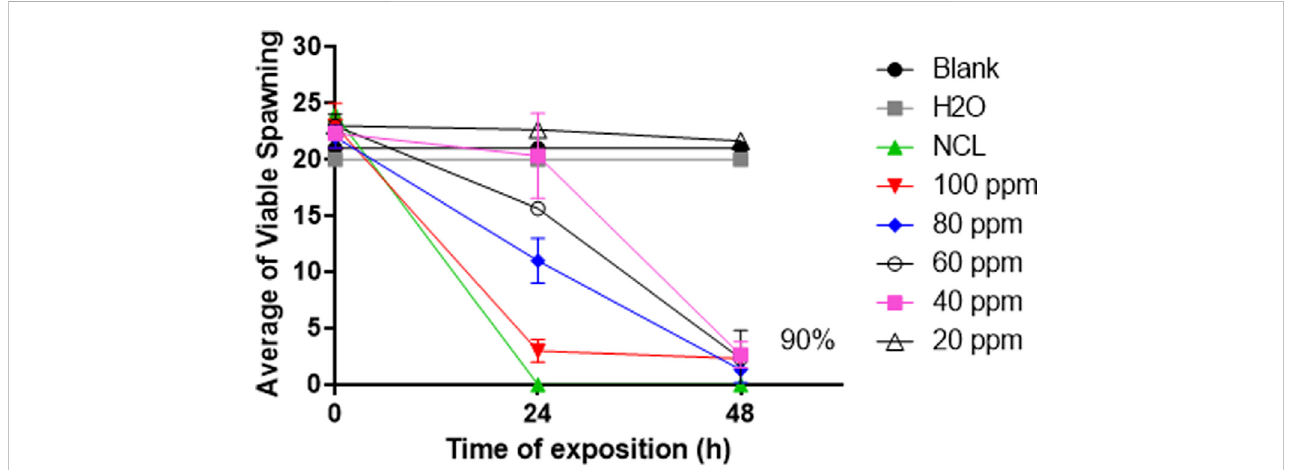
FIGURE 4 Effect of NE on the spawning of Biomphalaria glabrata in the period from 24 to 48 h. The test was repeated three different times in triplicate ( n = 9). A range of 20 – 25 spawns was used per well. These data are expressed as the mean ± S.D. The statistical test used was ANOVA 2-way, R 2 : 0.9793, p -value: < 0.0001.